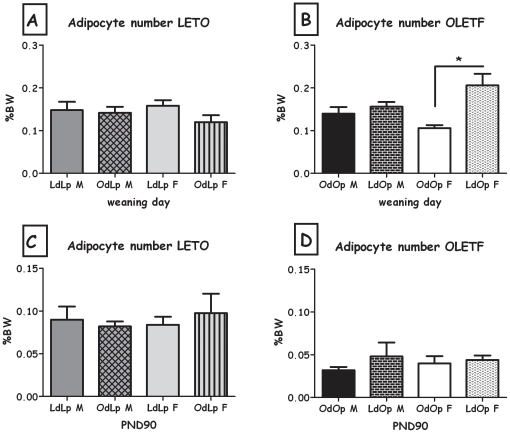
Estimation of the adipocyte number (expressed as percent of BW).
A: LdLp pups vs. OdLp pups at weaning; B: OdOp pups vs. LdOp pups at weaning; C: LdLp pups vs. OdLp pups on PND90; D: OdOp pups vs. LdOp pups on PND90. Data are presented in means and SEM. *p<0.05 for pup-strain comparison between same-sex cross and in-fostering groups. N = 4–6 per group.